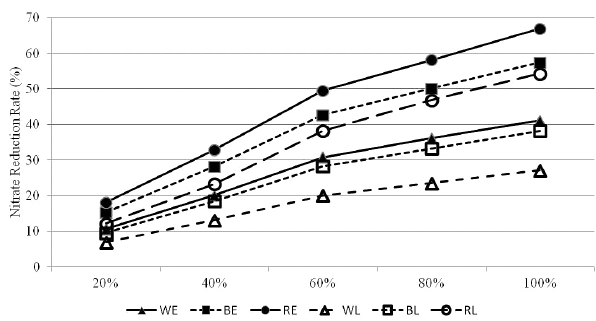
Figure 7. Nitrate reduction rates by varying degree of cover crop implementation at the field scale.